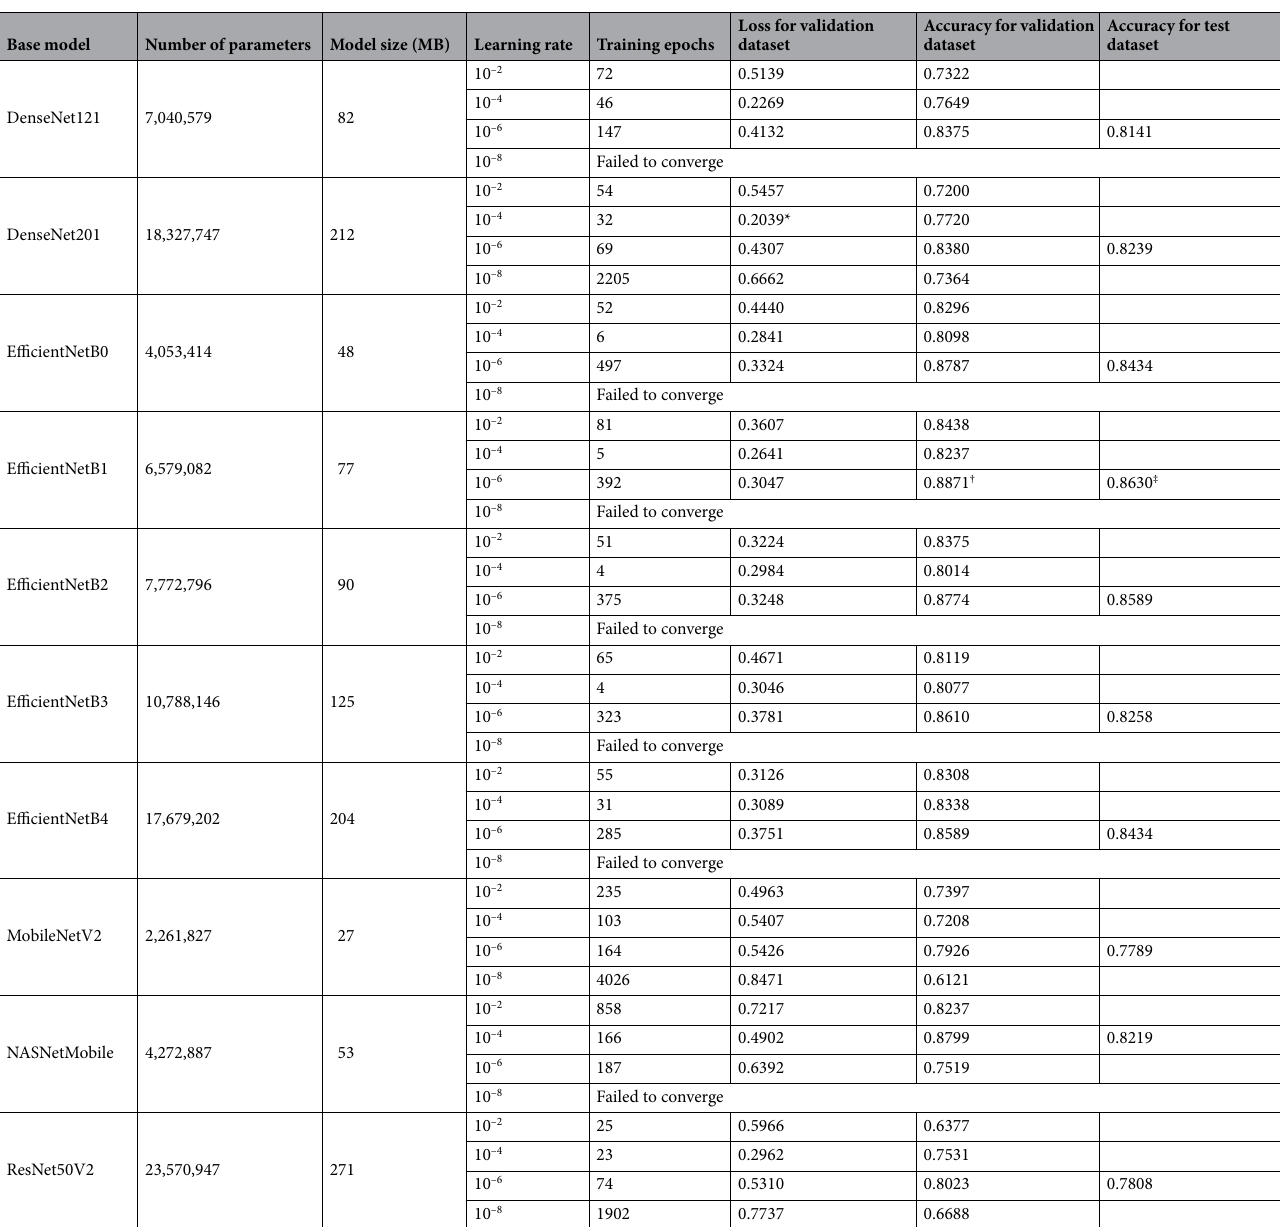
Table 1. Training results according to the base models used for custom model design and initial learning rate. MB megabytes. *The lowest loss value. † The highest accuracy for validation dataset. ‡ The highest accuracy for test